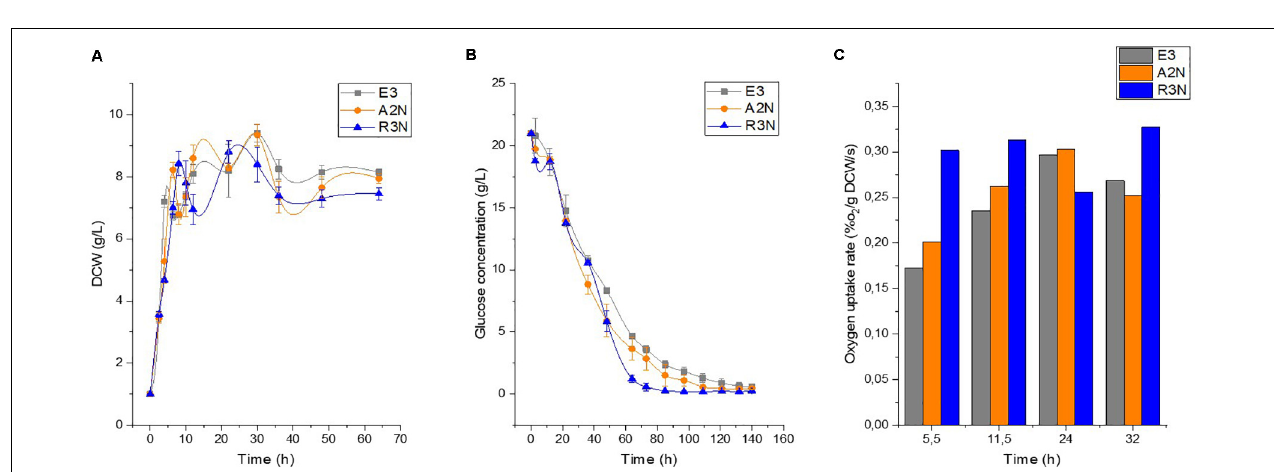
FIGURE 2 | In vitro activity of NOX (A) and intracellular [NADH]/[NAD + ] ratios (B) . D1N, A2N, and R3N indicate the NOX-expression strains with promoter D1W12 p, 2A23 p and ermE* p, respectively. **, P -value < 0.01.